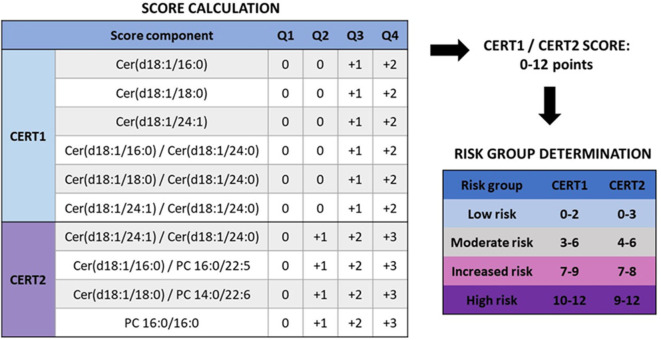
Calculation of CERT2 risk scores and determination of CVD risk groups (14). When determining the score for a subject, it is evaluated to which quartile the person belongs with regards to each score component. CERT1 has six components, and only quartiles 3 and 4 give points, while CERT2 has only 4 components but already the second quartile yields a risk point. Thus, the scale for both of these scores is the same, 0–12 points. Based on these the subject is categorized to one of the CVD risk categories. Figure reproduced under the terms of the Creative Commons Attribution License.